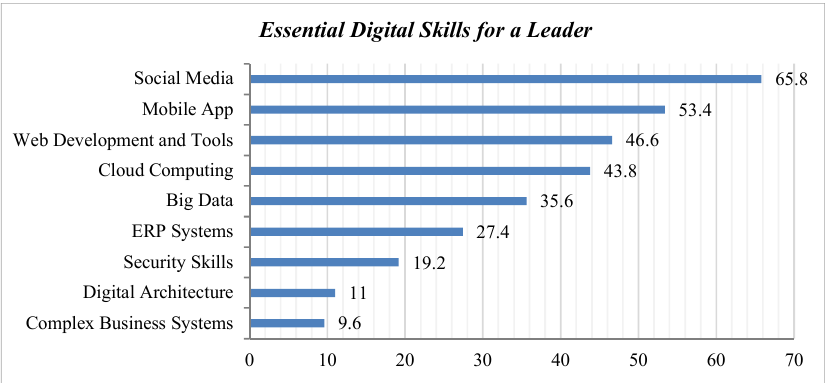
Figure 8. Digital